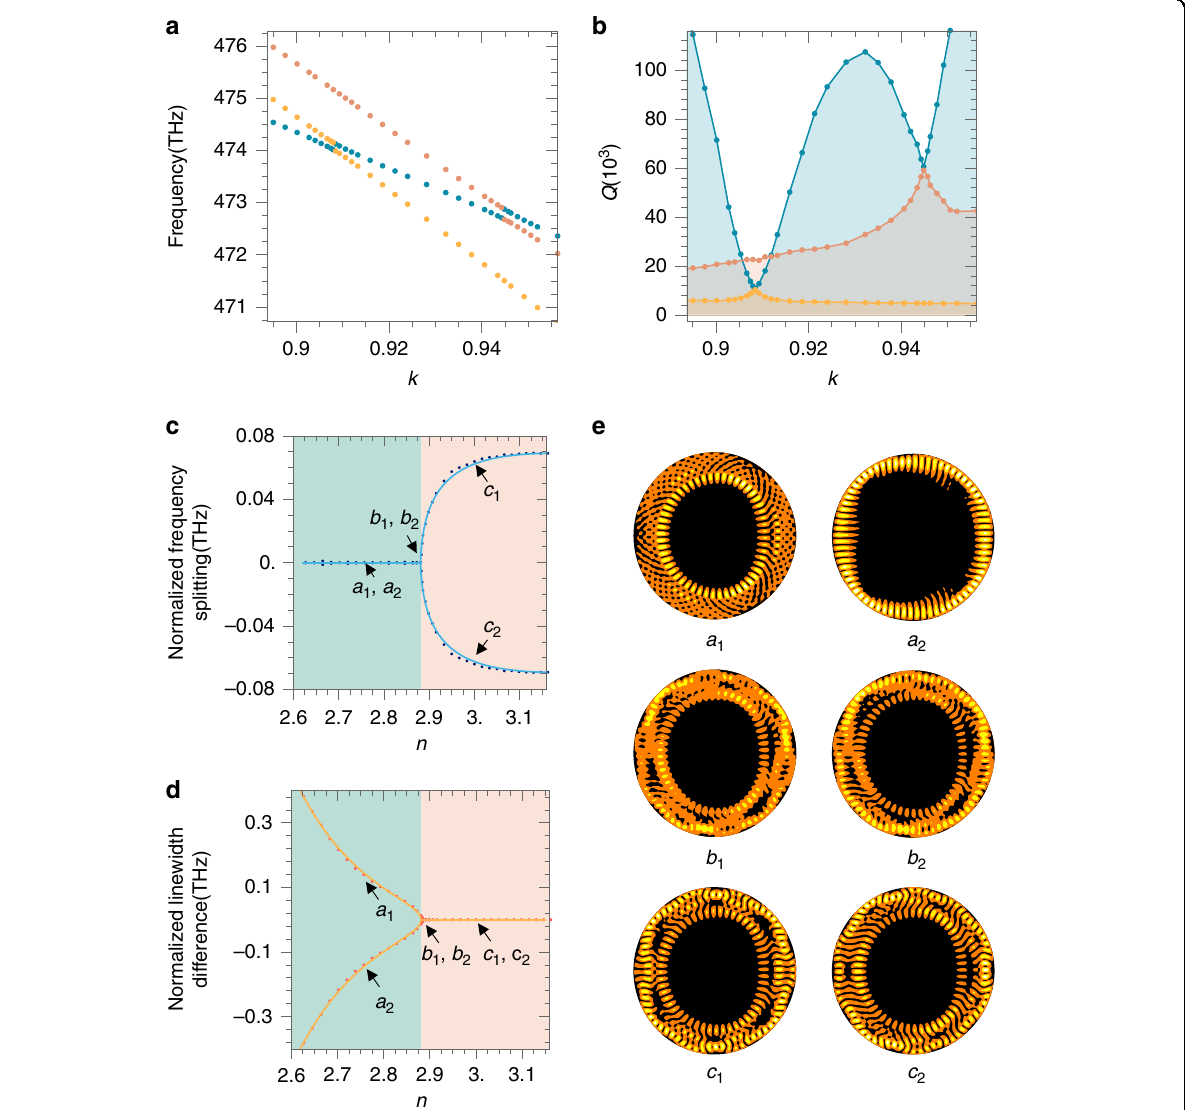
Fig. 3 Geodesic mode coupling and non-Hermitian EP. a Mode frequencies as a function of k , showing anti-crossing features at each resonant point. b The Q-factor of mode a as a function of k . c , d The splittings of the real ( c ) and imaginary ( d ) parts of the eigenvalues of the hybrid modes formed by the coupling between modes a and d , as a function of the material refractive index n . e The electric fi eld distributions (top view) of the corresponding points a 1 , a 2 , b 1 , b 2 and c 1 , c 2 in c and d . The degenerate points b 1 and b 2 correspond to the EP. Note here the letters a 1 to c 2 are used to label the points in this fi gure and are not associated with the labeling of different